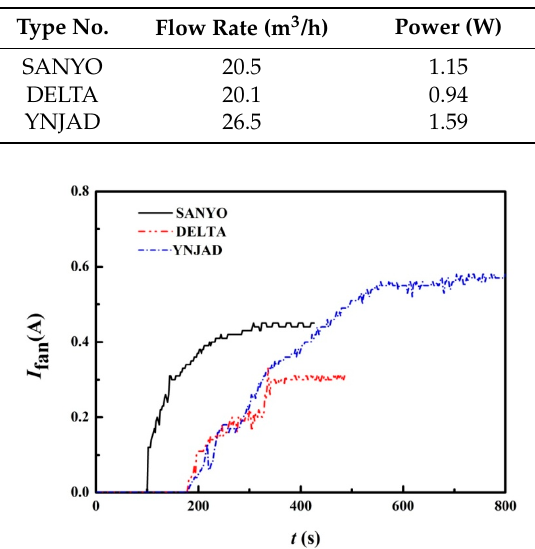
Figure 8. Influence of cooling fan selection on the STEG startup performance (HS1 heat sink, Cod1 heat conducting plate and Cof1 configuration).